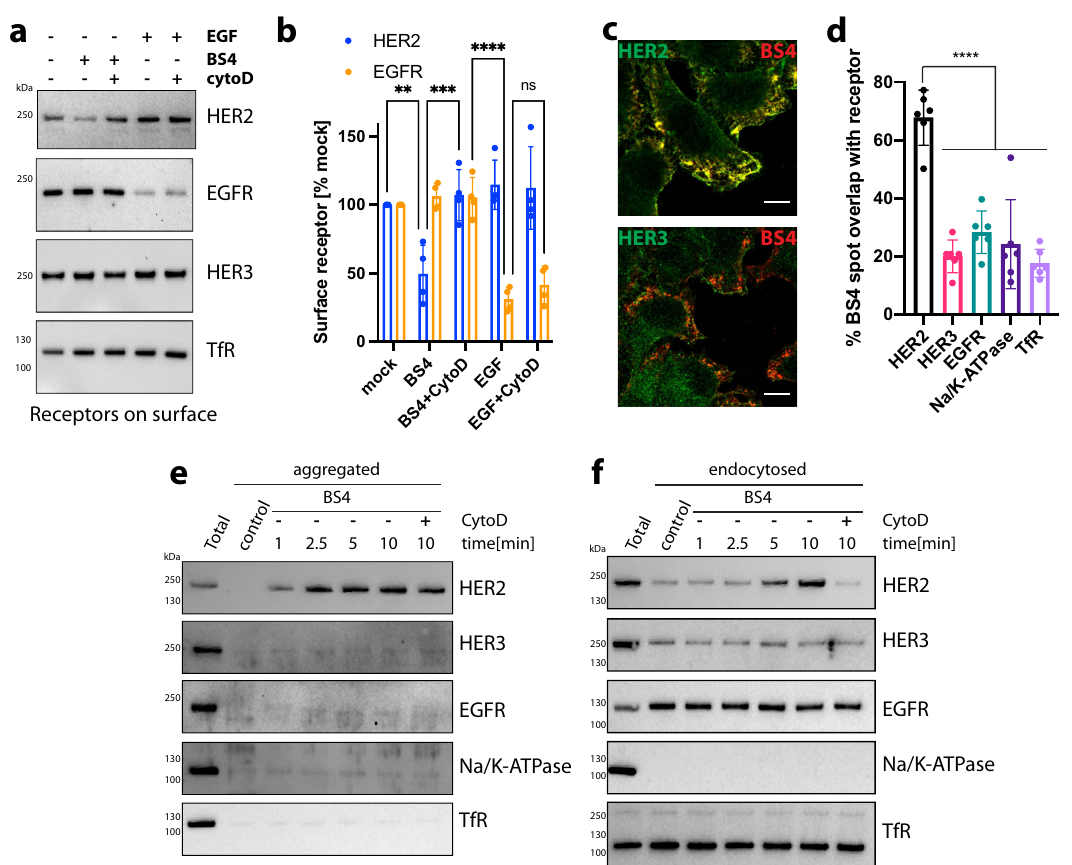
Fig. 6 | BS4-triggered aggregation and actin-dependent macroendocytosis is HER2-speci fi c. a , b Depletion of HER2 and EGFR surface receptor levels by treat- ment with BS4 and EGF, respectively. SkBr3 cells were incubated for 10min with BS4orEGF,and±CytochalasinD(CytoD)followedbycell-surfacebiotinylationand concentration on Streptavidin beads (surface). Samples were analysed by immu- noblotforHER2,EGFRandHER3,TfRasnegativecontrols( a ).Aquantitationofthe results is shown in ( b ) means±SD, n =4 independent experiments, ns (non-sig- ni fi cant) P >0.05, ** P =0.0051, *** P =0.0009, *** P <0.0001; two-way ANOVA with Sidak ’ s multiple comparison test. c , d BS4 clusters HER2 but no other receptors in the plasma membrane resulting in HER2-speci fi c endocytosis. SkBr3 cells were incubated with HER2-speci fi c, dylight650-labelled biparatopic antibody BS4 for 2.5min. After fi xation, total receptor tyrosine-protein kinase ErbB-2 (HER2), receptor tyrosine-protein kinase ErbB-3 (HER3), epidermal growth factor receptor (EGFR), sodium/potassium-transporting ATPase Alpha1 (Na/K-ATPase) and